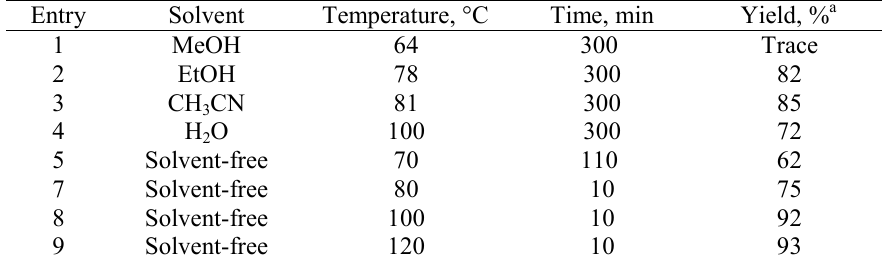
Table 1. Synthesis of 1,8-dioxodecahydroacridine 3a in the presence of PPA-SiO 0.0100 mmol H + ) 22 in different solvents and optimization of temperature in solvent-free conditions.